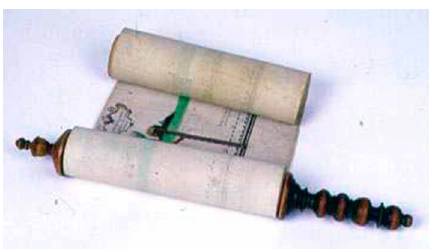
Fig. 3. Phendler’s map on a wooden